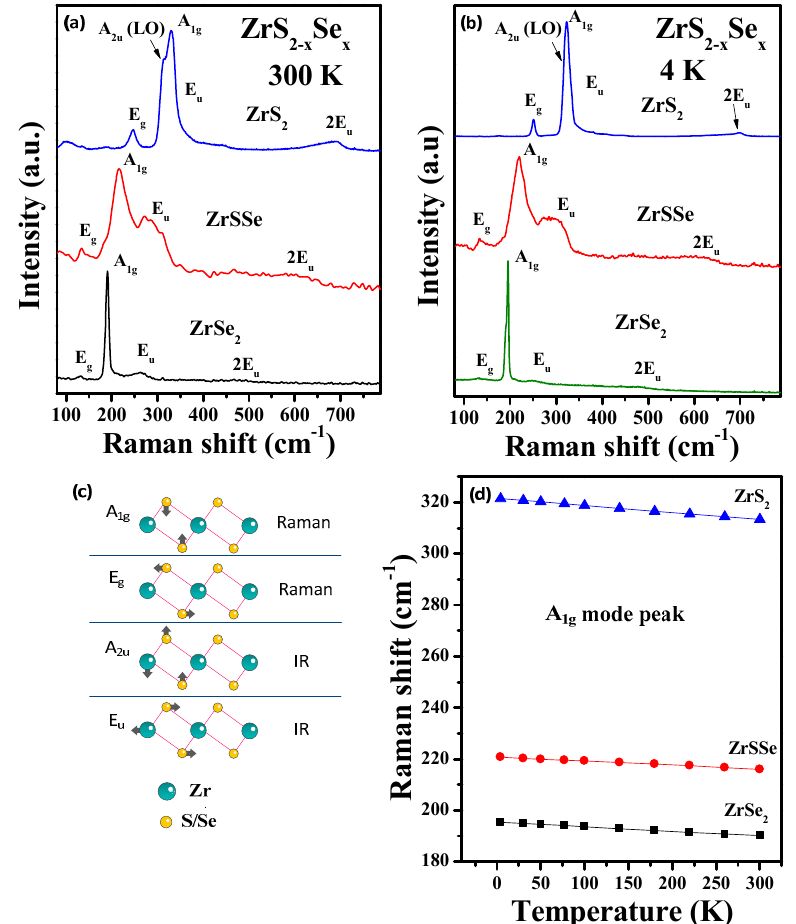
Figure 2. Raman spectra of ZrS 2 − x Se x (x = 0, 1, and 2) at ( a ) 300 K and ( b ) 4 K. ( c ) The illustration of atomic movements of vibrational modes. ( d ) Raman frequency of A 1g mode as a function of temperature in ZrS 2 − x Se x (x = 0, 1, and 2).